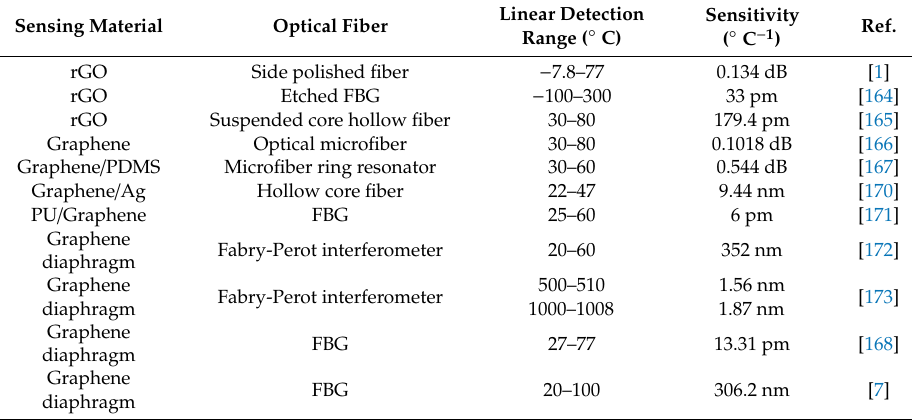
Table 4. Summary of carbon allotrope-based OFS for temperature sensing.